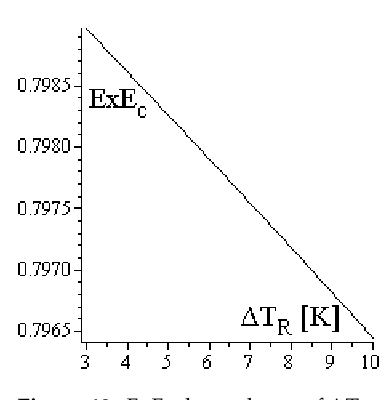
Figure 11. ExE b dependence of Δ T H .